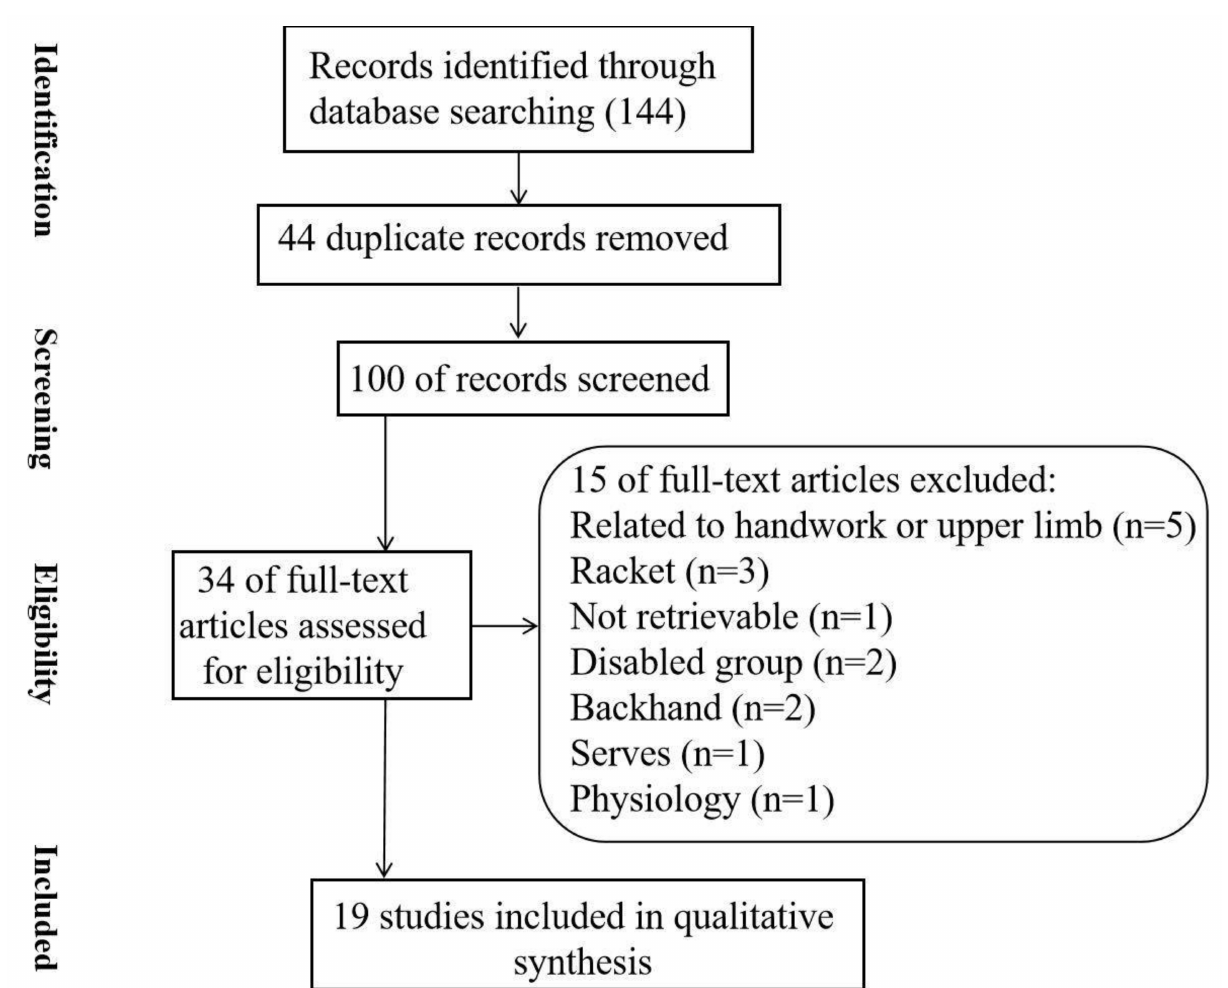
Figure 1. Flowchart of the systematic search and selection